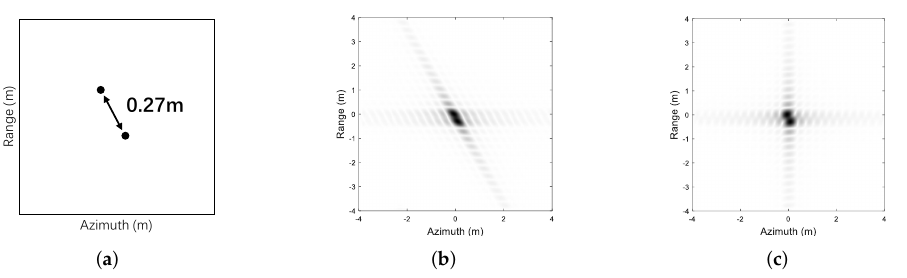
Figure 6. Illustrations for ( a ) two targets focused by ( b ) constant parameter BPA and ( c ) continuously time-varying parameter